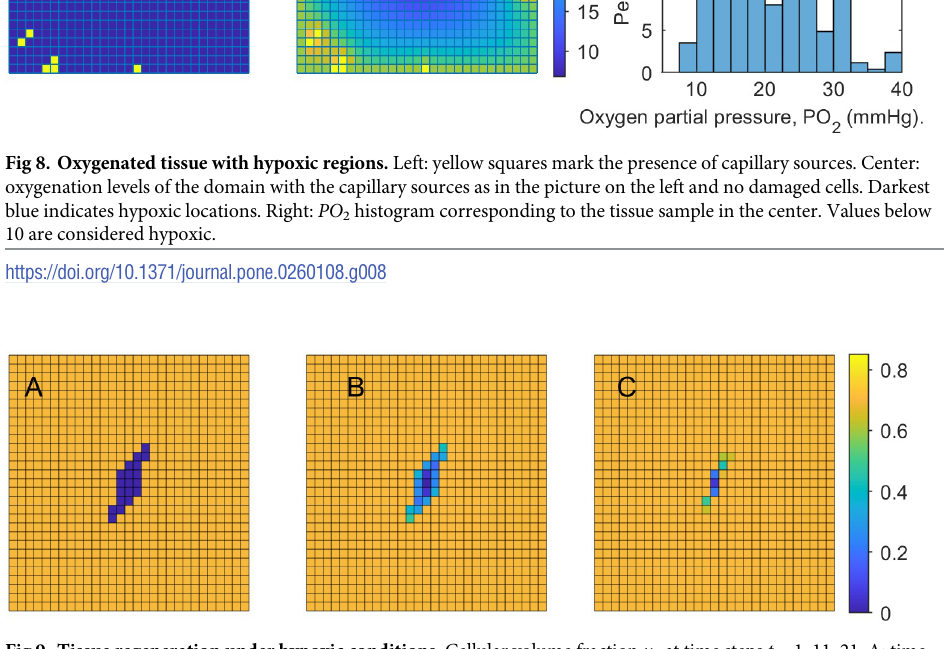
Fig 9. Tissue regeneration under hypoxic conditions. Cellular volume fraction u 1 at time steps t = 1, 11, 21. A: time step t = 1, B: time step t = 11, C: time step t = 21. These results demonstrate that the healing process in hypoxic tissue is much slower, compared to well oxygenated